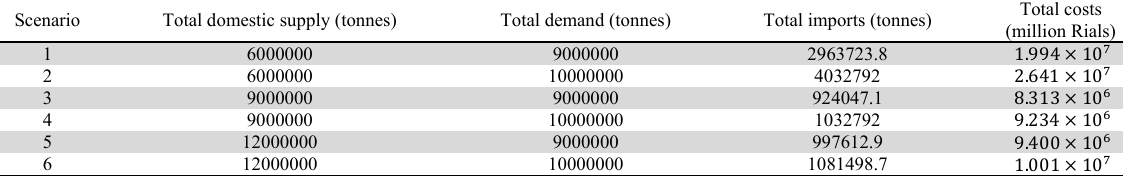
The values of the objective functions